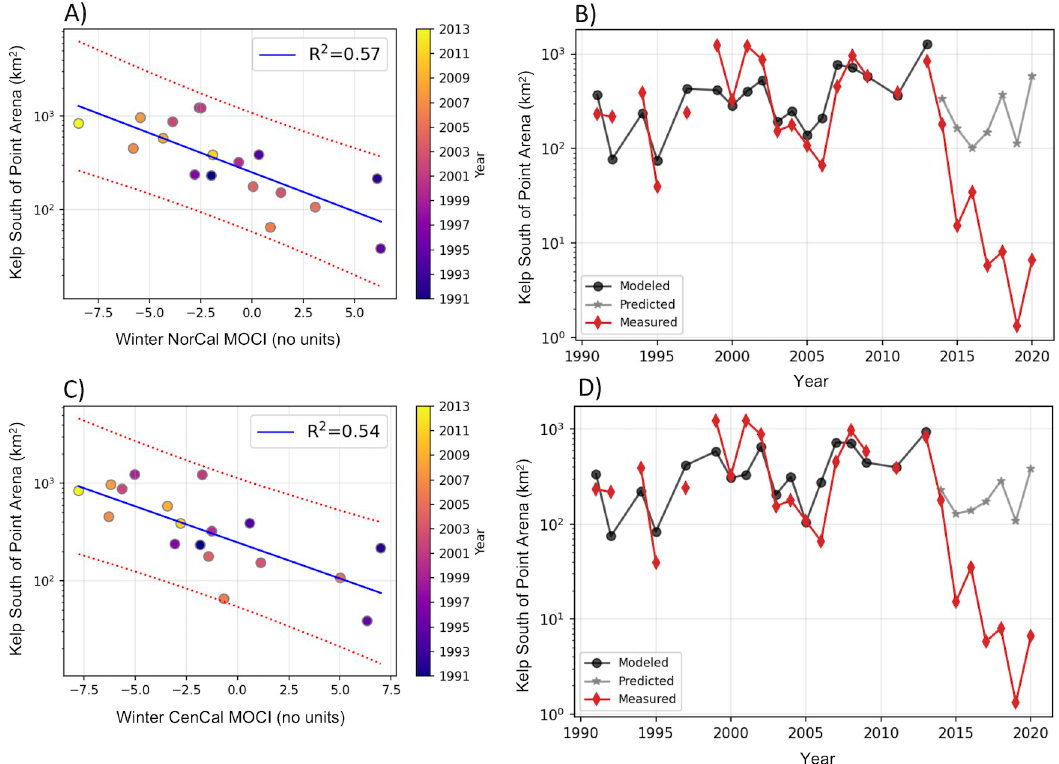
Fig 3. Linear regression between canopy coverage south of Point Arena and MOCI. Same as Fig 2 for regressions between kelp canopy south of Point Arena and northern California MOCI (NorCal MOCI; (A) and (B)) and central California MOCI, (CenCal MOCI; (C) and (D)).